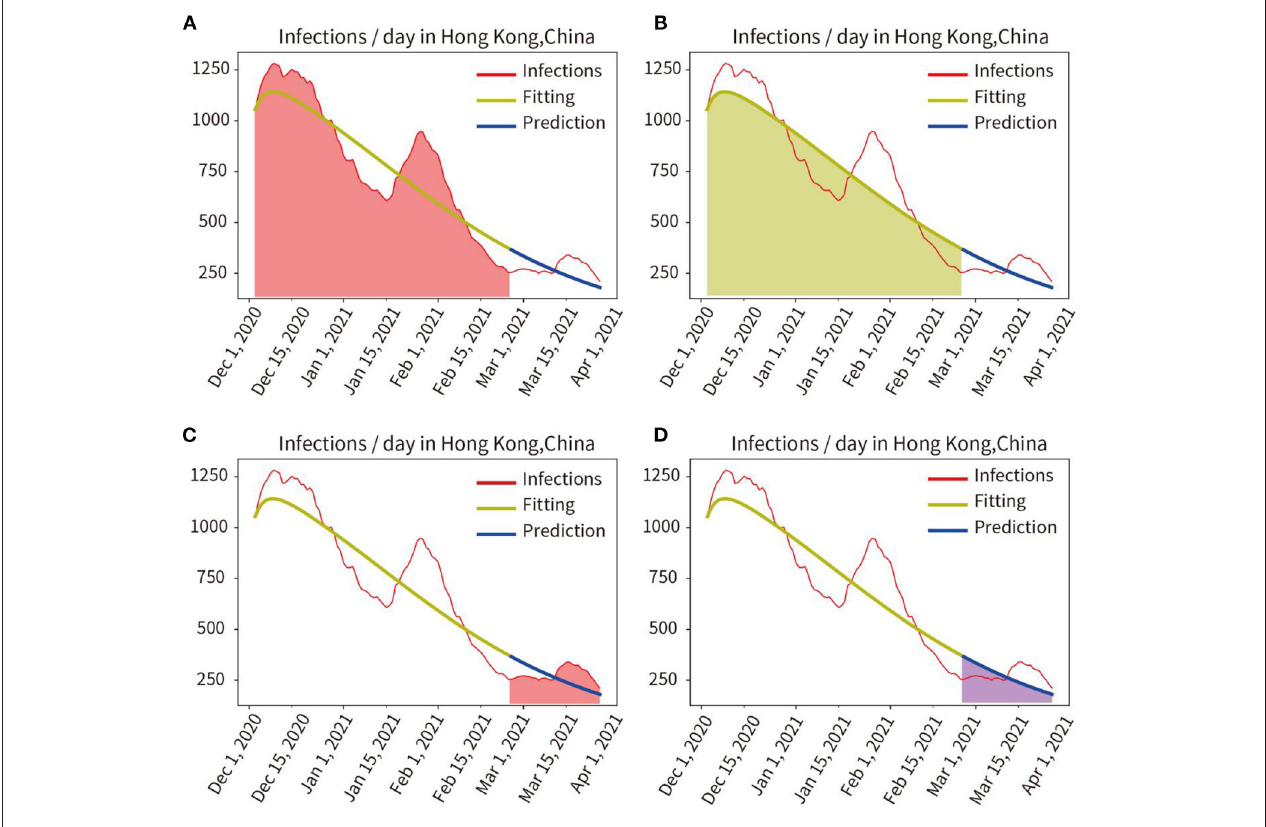
FIGURE 2 | Quantitative analysis of fitting and prediction for HongKong. (A) Red area represents the integral under the curve of actual infections during the fitting period. (B) Yellow area represents the integral under the curve of the fitted infections during the fitting period. (C) Red area indicates the integral under the curve of actual infections in the prediction period. (D) Blue area represents the integral under the curve of predicted infections in the prediction period.